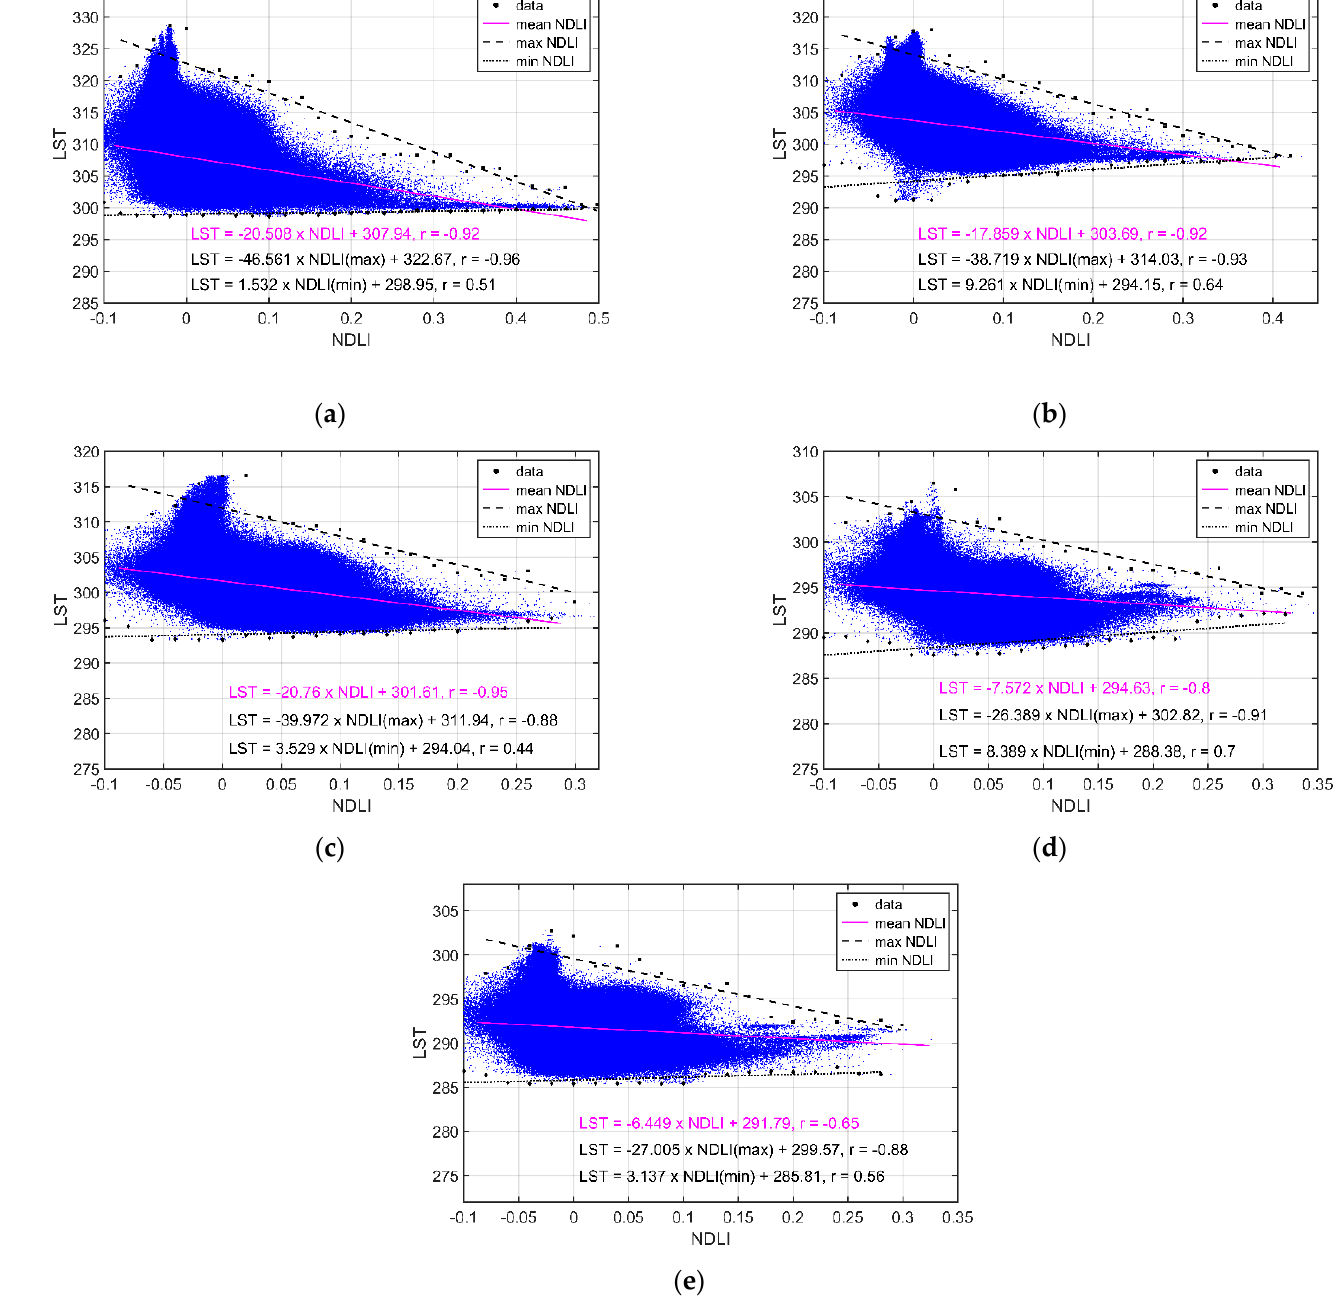
Figure 4. Dry/wet edges and their fitting equations derived from scatterplots of NDVI and LST on 19 October ( a ), 4 November ( b ), 20 November ( c ), 6 December ( d ), and 22 December 2014 ( e ).